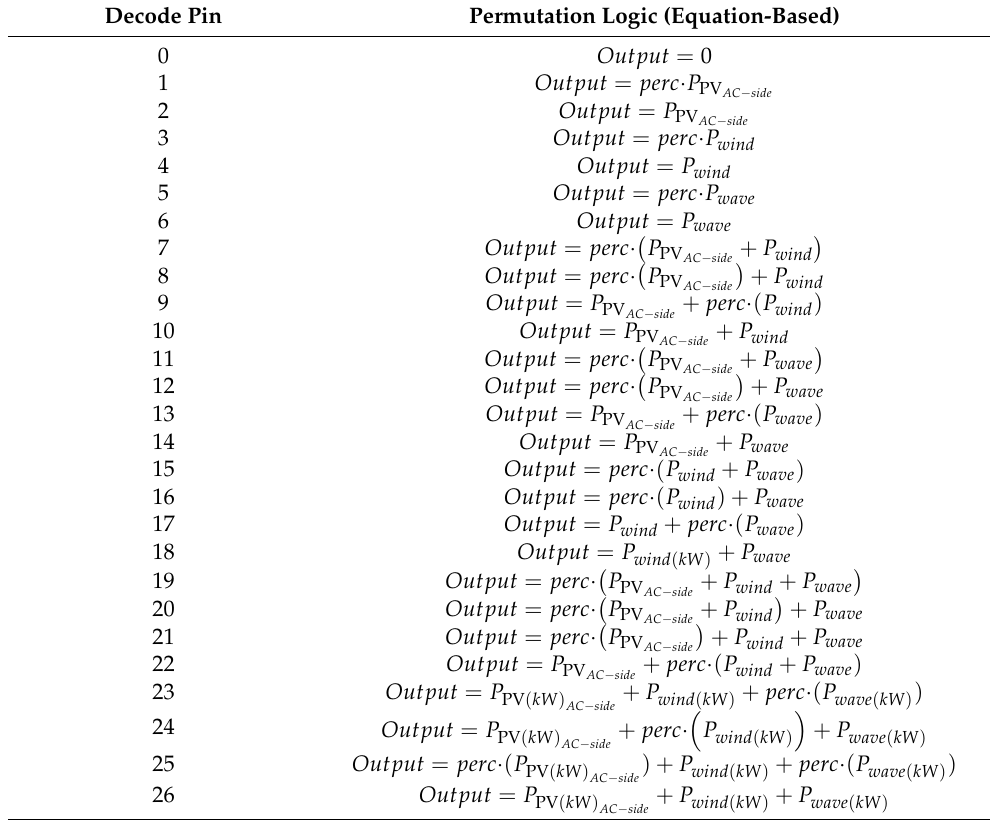
Table 3. Proposed permutation logic based on 3-8